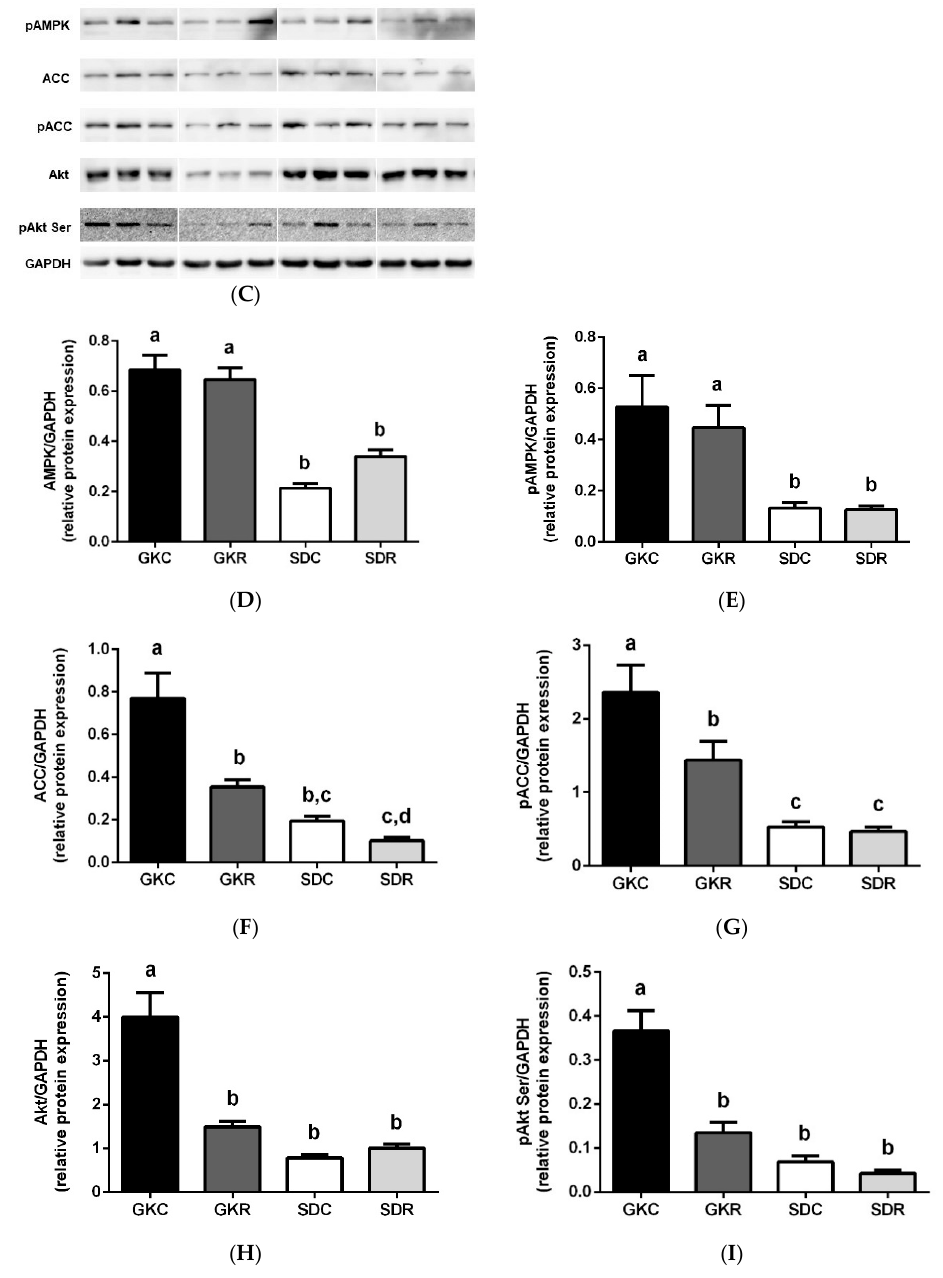
Figure 3. Effects of resveratrol on skeletal muscle lipids, and also expression and phosphorylation of activated protein kinase (AMPK), acetyl-CoA carboxylase (ACC) and protein kinase B (Akt) in muscle tissue of GK and SD rats. Triglycerides ( A ), non-esterified fatty acids ( B ). Western blot immunodetection with antibodies to the indicated proteins, GAPDH expression used as loading control ( C ). Protein levels relative to GAPDH quantified by densitometry: Total AMPK ( D ) and phosphorylation (pAMPK) ( E ), total ACC ( F ) and phosphorylated fraction (pACC) ( G ), total Akt ( H ) and pAkt ( I ). Results are representative of at least two independent experiments. GKC—Goto-Kakizaki control rats, GKR—Goto-Kakizaki resveratrol-treated rats, SDC—Sprague–Dawley control rats, SDR—Sprague–Dawley resveratrol-treated rats. Results are expressed as the means ± SEM from 10 rats in each group. Values with di ff erent letters are significantly di ff erent at p <